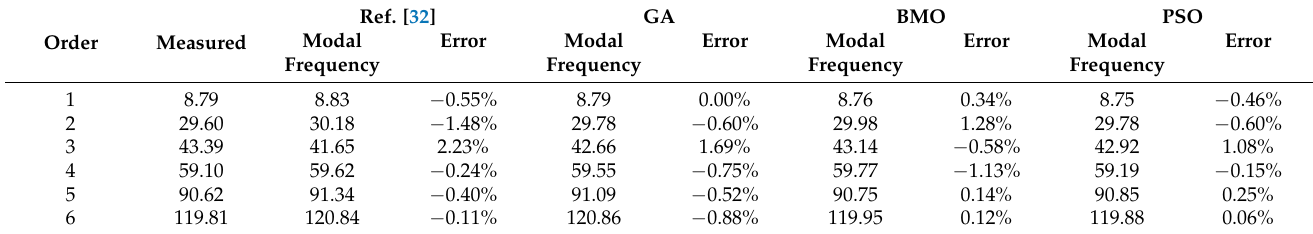
Table 1. Comparison of optimization results of truss model (Unit: